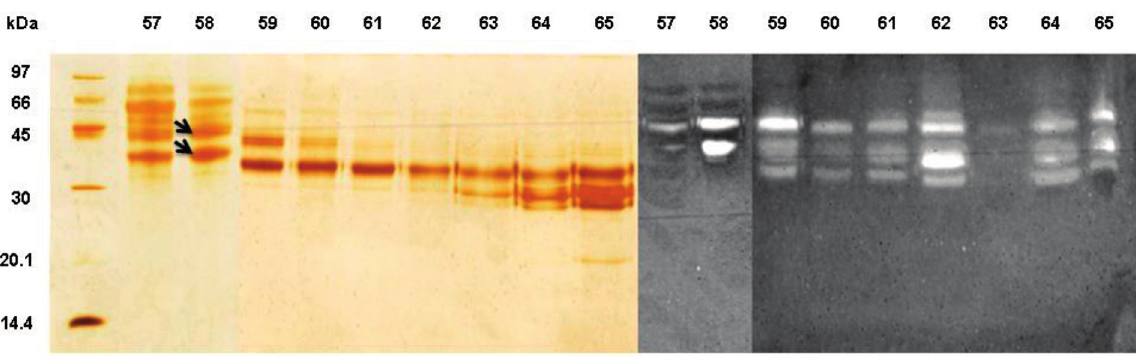
Figure 3. SDS-PAGE (12%) of fractions collected from chromatography on Sephacryl S-100 and stained with silver nitrate ( left ). MW (molecular weight) marker: phosphorylase b (97 kDa), albumin (66 kDa), ovalbumin (45 kDa), carbonic anhydrase (30 kDa), trypsin inhibitor (20.1 kDa) and α -lactalbumin (14.4 kDa). Zymogram of chromatography fractions ( right ); the arrows ( left ) indicate protein bands corresponding to β -mannanase activity ( right ) at fraction